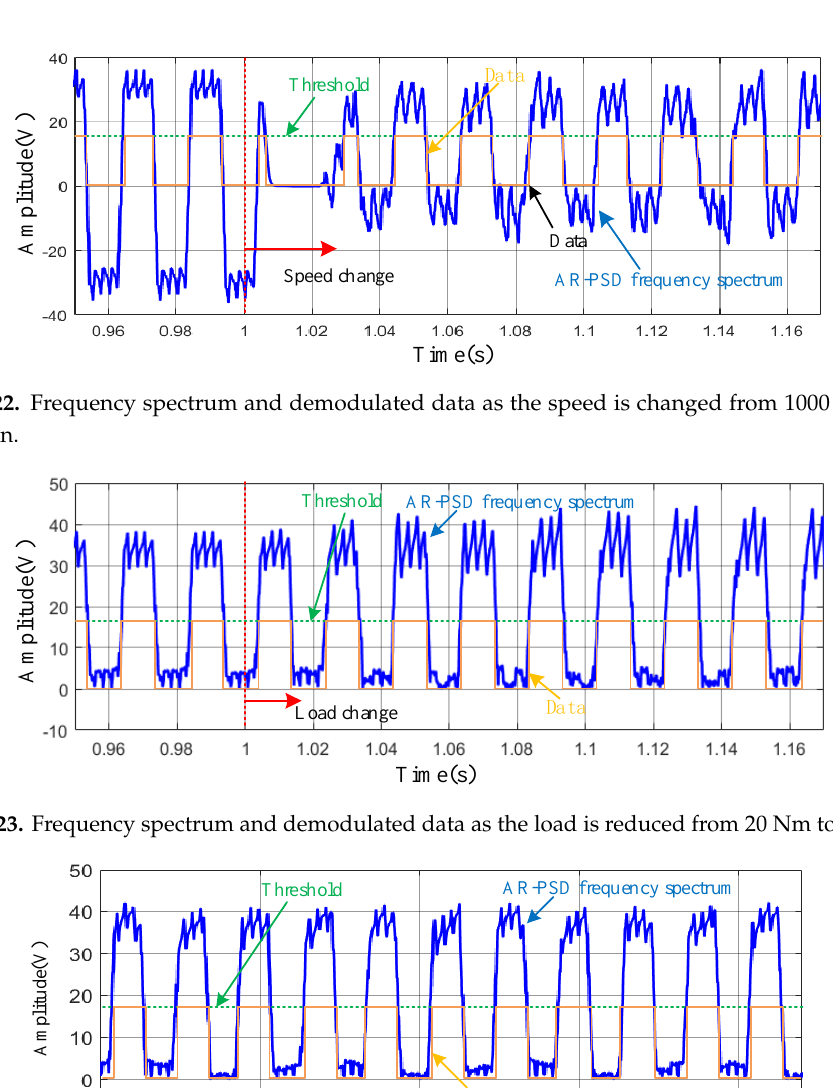
Figure 25. Frequency spectrum with similar frequency.